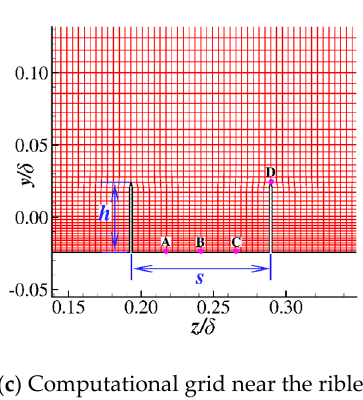
Figure 2. Wall-normal Δ y + and spanwise Δ z + on the riblet side.